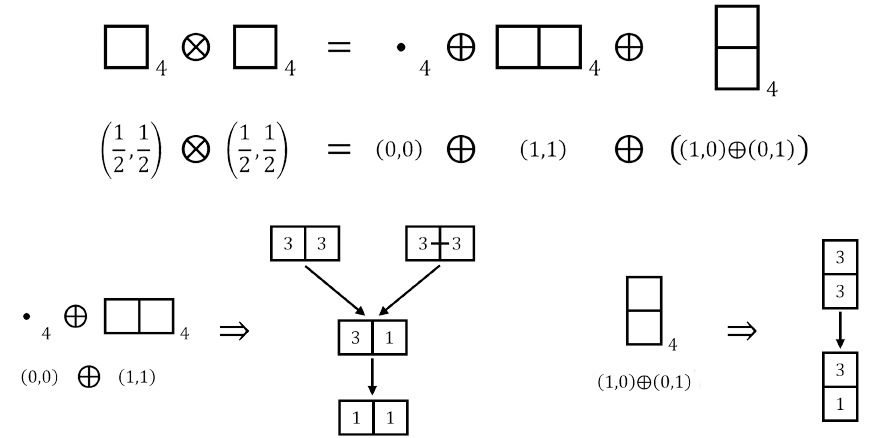
Figure 14: The rank-2 tensor representation of SO ( 4 ) and their Inonu-Wigner con- traction of the Carrollian